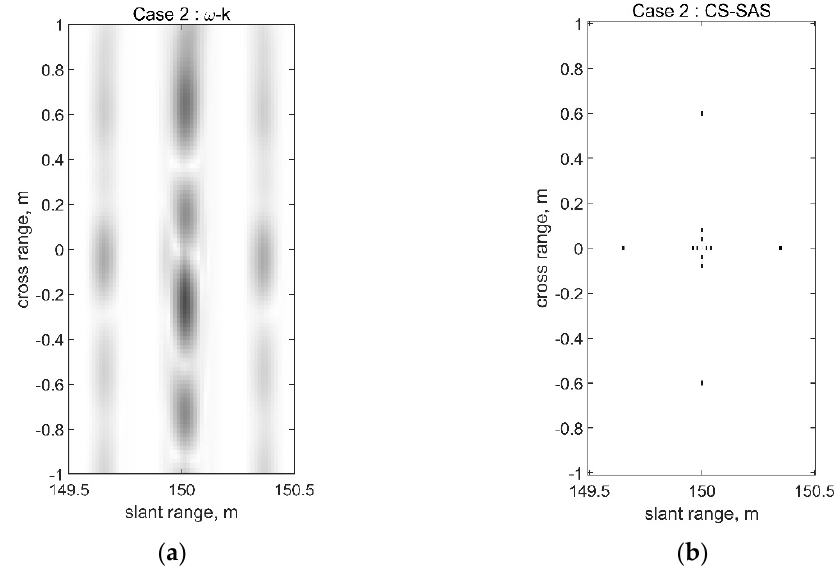
Figure 12. Simulation results for Case 2 for uniform line array: ( a ) result for the ω -k algorithm; ( b ) result for the CS-SAS algorithm for a uniform line array.